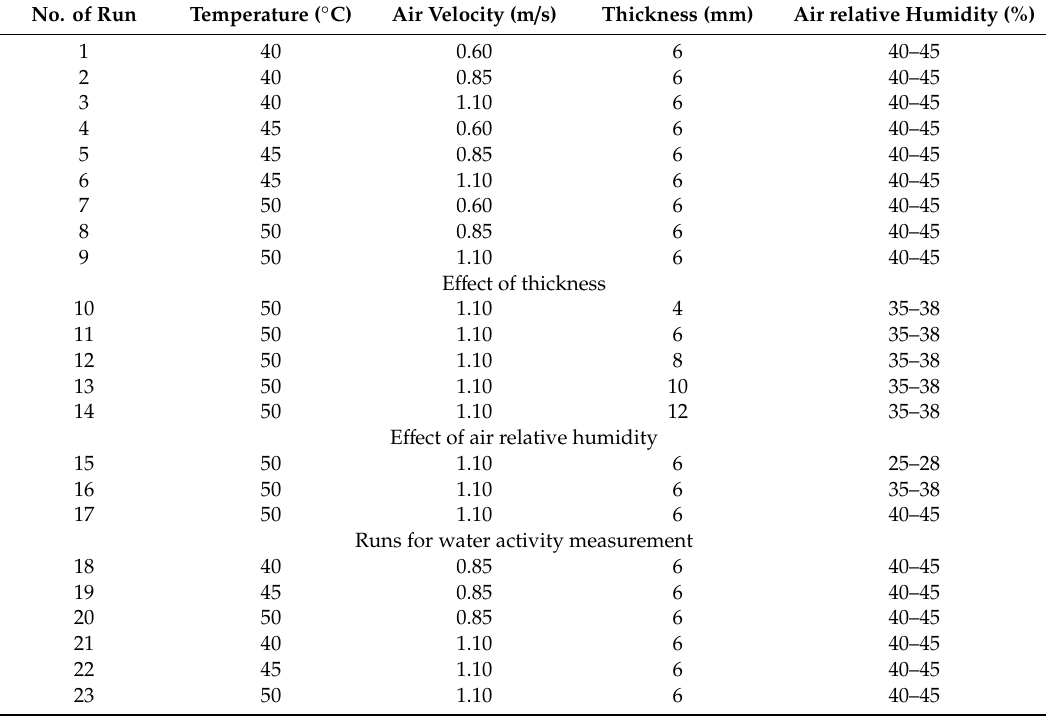
Table 1. List of experimental runs.